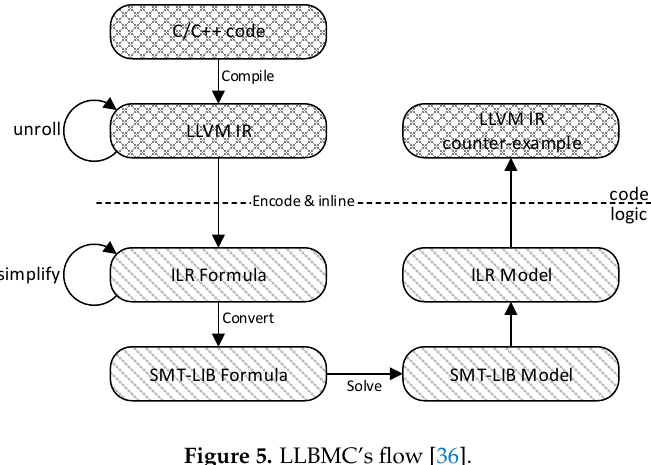
Figure 5. LLBMC’s flow